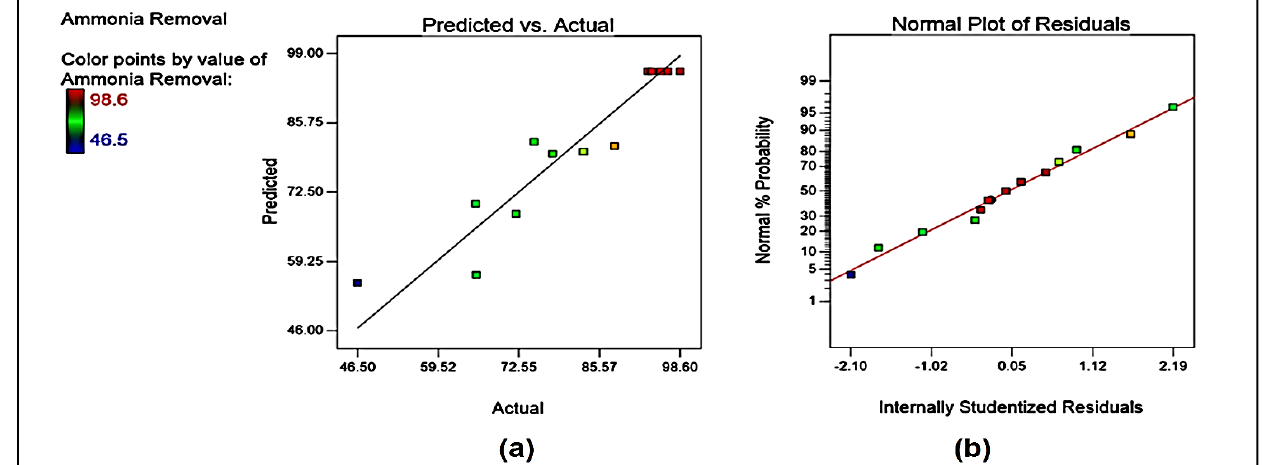
Figure 4. Predicted versus actual values plot (a) and normal probability plot (b) of the studentized residual for bioelectrochemical ammonium